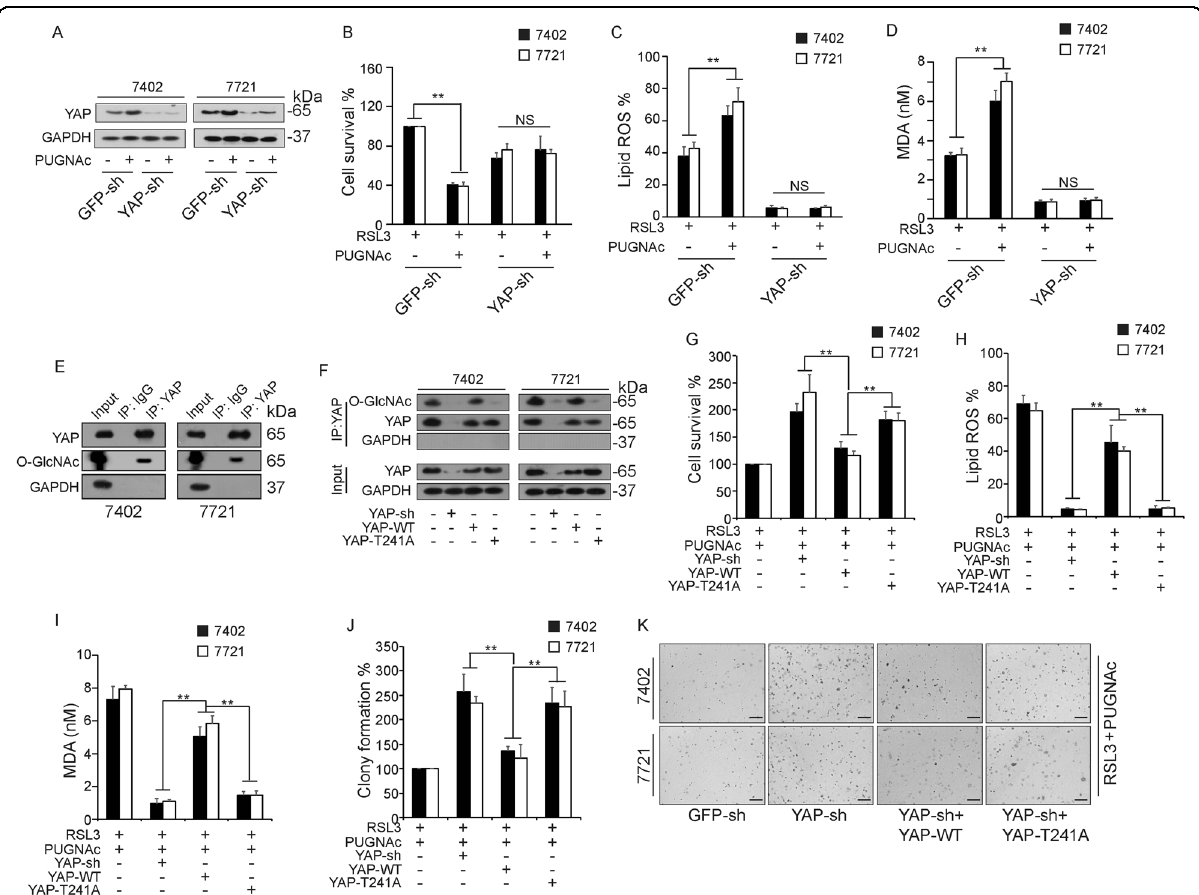
Fig. 2 YAP O-GlcNAcylation mediates the ferroptosis sensitivity of HCC cells. A YAP expression levels were determined in control and YAP knockdown Bel-7402 and SMMC-7721 cells treated with PUGNAc. B – D After RSL3 pretreatment, ferroptotic events were evaluated in control and YAP knockdown Bel-7402 and SMMC-7721 cells treated with PUGNAc: cell death ( B ), lipid ROS production ( C ), and MDA production ( D ). E Interaction between O-GlcNAc and YAP using anti-YAP antibody with input as control. F – I Bel-7402 and SMMC-7721 cells were transfected with YAP-sh, and YAP-WT or YAP-T241A was simultaneously overexpressed. Endogenous YAP was immunoprecipitated, and O-GlcNAcylation of YAP was detected by WB ( F ). After RSL3 and PUGNAc pretreatment, ferroptotic events were evaluated in control and transfected Bel-7402 and SMMC-7721 cells: cell death ( G ), lipid ROS production ( H ), and MDA production ( I ). J , K After RSL3 and PUGNAc pretreatment, the colony formation capacity was measured using a soft agar assay in control cells, and Bel-7402 and SMMC-7721 cells transfected with YAP-sh with simultaneous overexpression of YAP-WT or